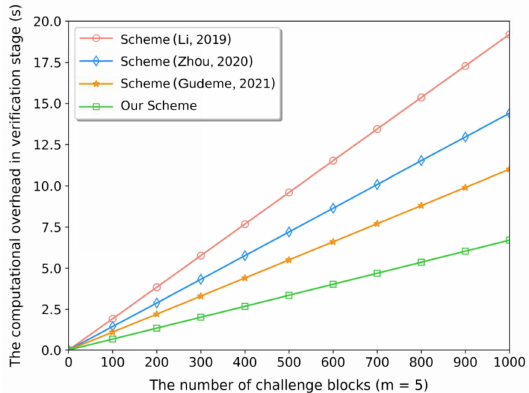
Figure 8. The computational overhead for signature generation [21,24,35].